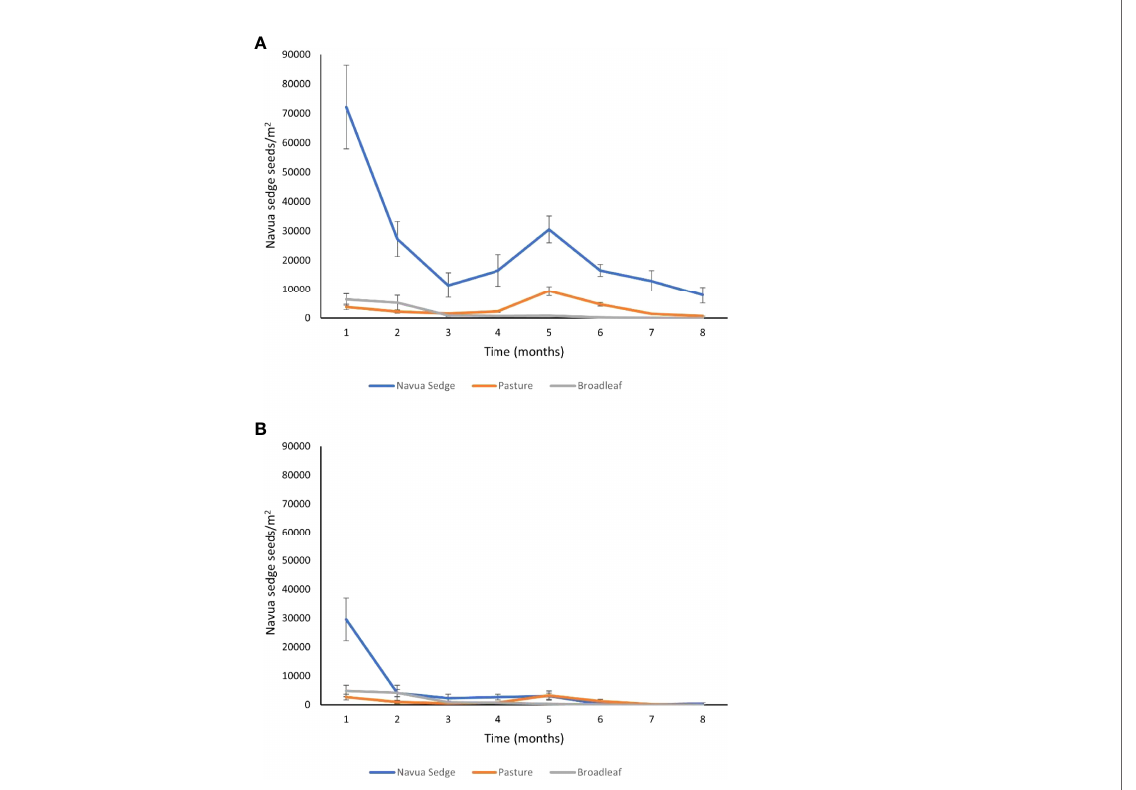
FIGURE 2 | Monthly emergence of Navua sedge (blue), pasture (orange) and broadleaf (grey) seeds/m 2 averaged across all the sites (mean ± standard error) in (A) 0-5 cm of the soil and (B) 5-10 cm of the soil.